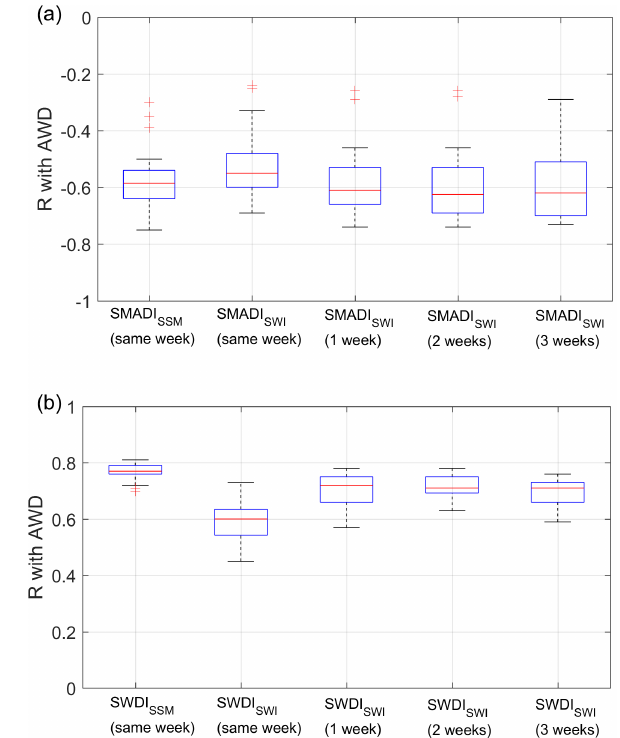
Figure 3. Correlation ( R ) of the SMADI (a) and the SWDI (b) obtained using the SMOS SSM and SWI, with the AWD of the same week and 1, 2 or 3 antecedent weeks at the 22 Inforiego stations and Villamor. All values were significant ( p -value<0.05).